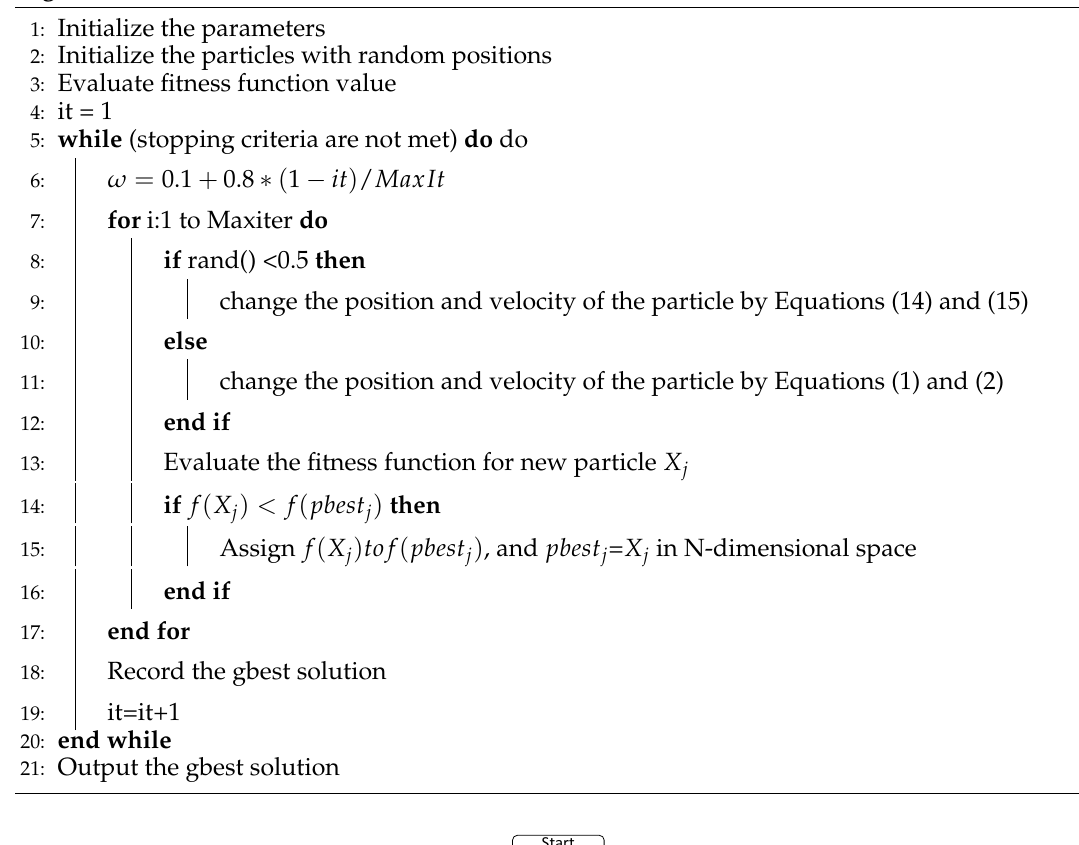
Algorithm 1 Pseudocode of the PSOLF